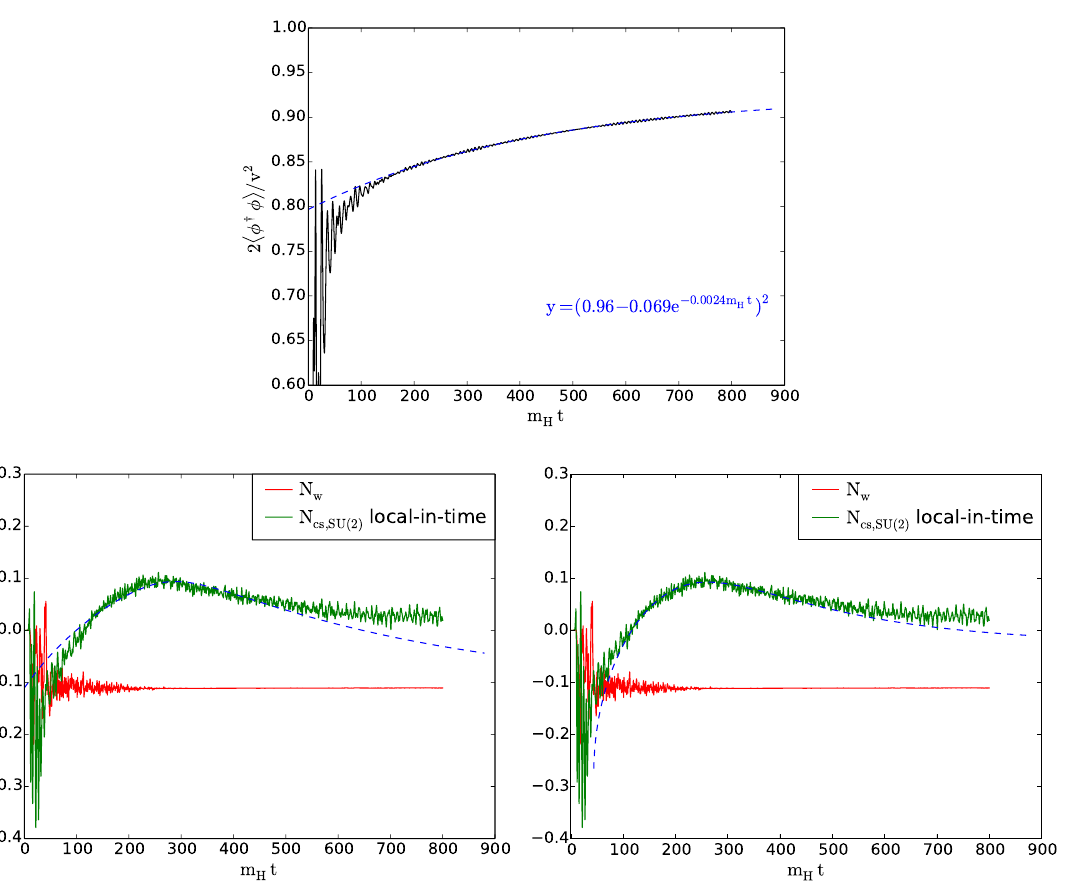
Figure 10 . The Higgs (cid:12)eld appproach to the vev (top). Fits to our simple model with one free parameter (bottom left) and four free parameters (bottom right). n =